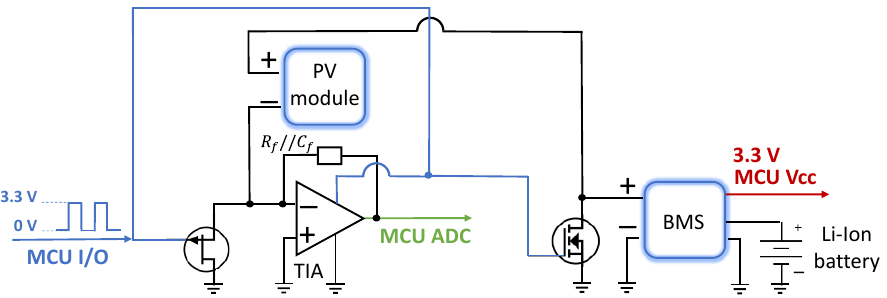
Figure 6. Implemented strategy, relied on a control signal from an I/O port of the MCU, to manage the same PV module both for energy harvesting and for localization estimation.